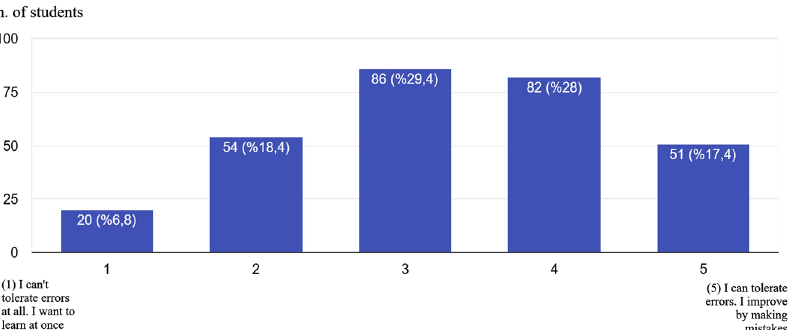
Figure 6: Students ’ level of tolerance to errors